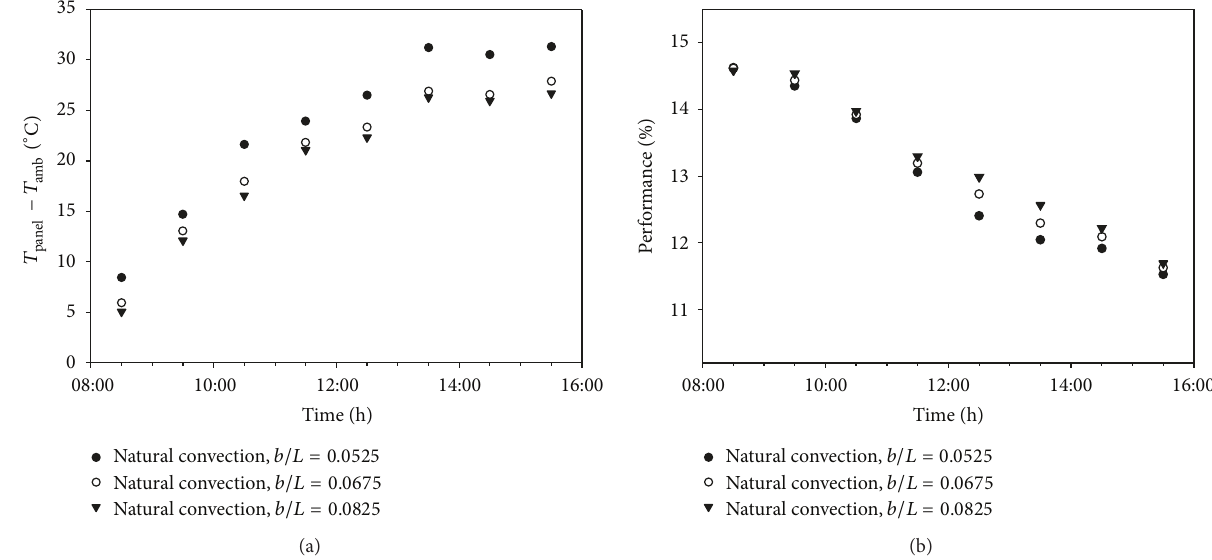
Figure 5: Influence of the aspect ratio at the natural convection configuration. (a) On the panel temperature. (b) On the performance.